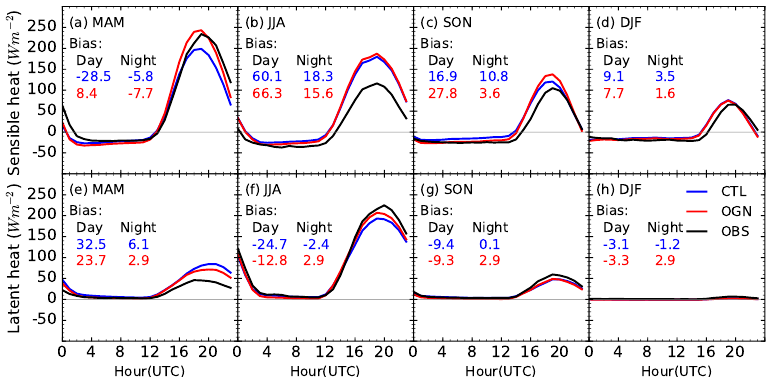
Figure 9. Comparison of the seasonal averaged diurnal cycle of the sensible and latent heat fluxes at OAS site for wet years.